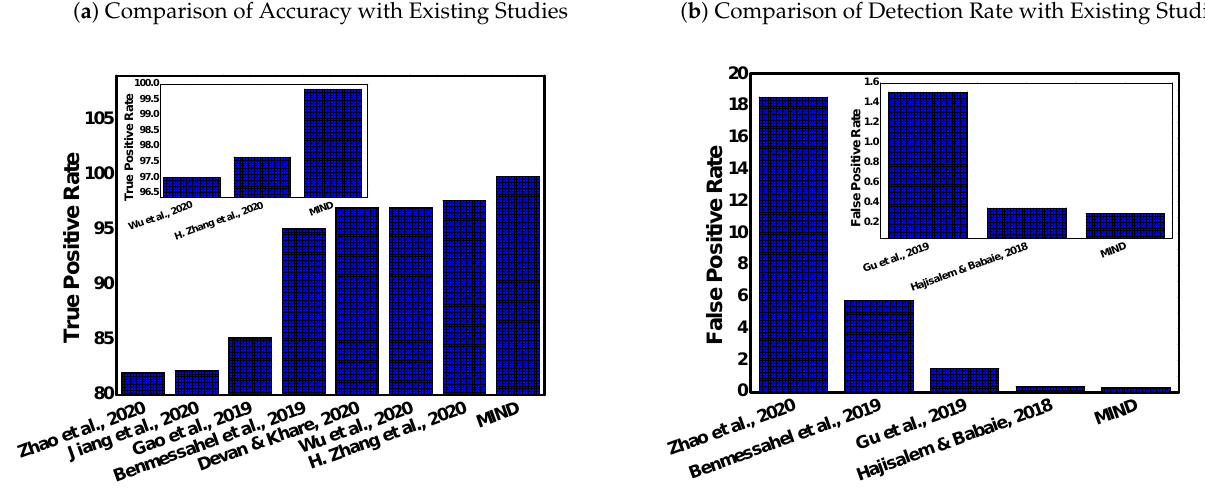
( d ) Comparison of FPR with Existing Studies Figure 5. Comparative analysis with existing